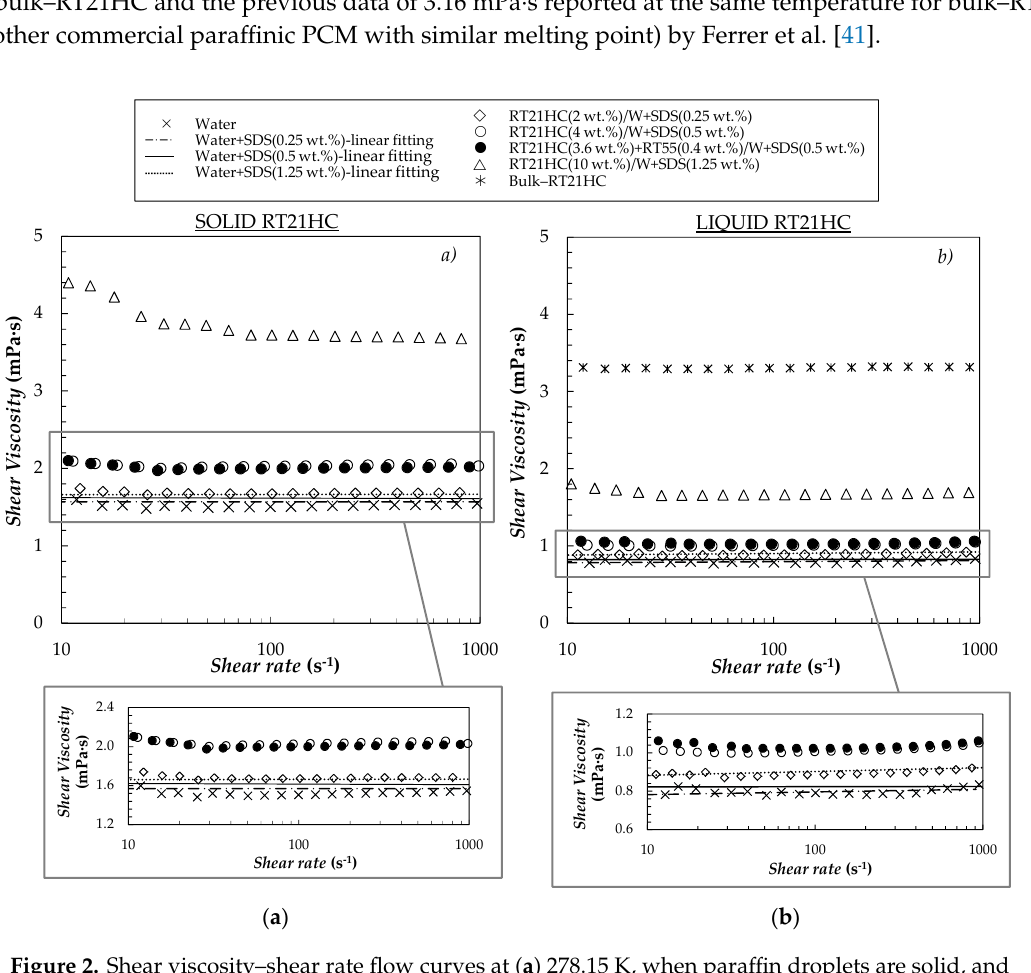
Table 1. Dynamic viscosities, µ , and viscosity increases regarding to water, µ / µ water , obtained for the different samples at ~100 s − 1 .